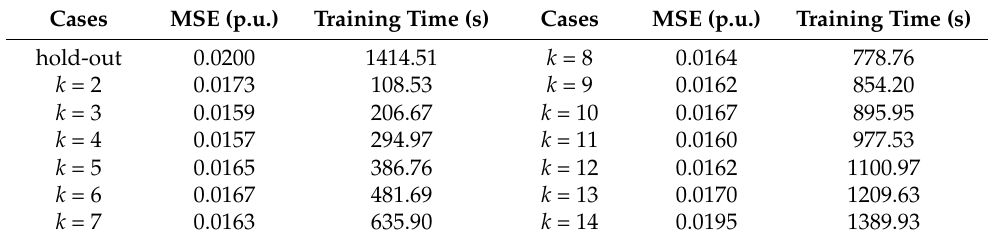
Table 1. Results of ensemble models with different